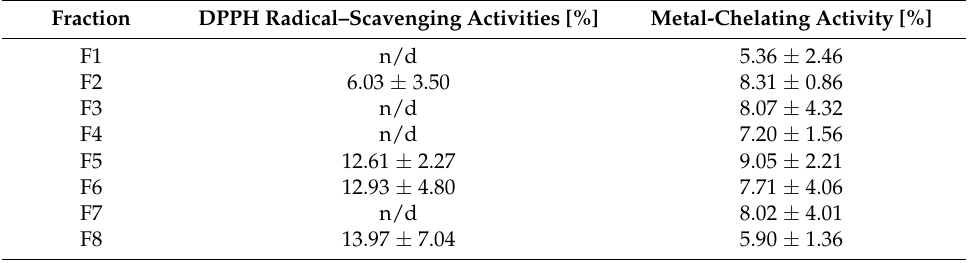
Table 2. DPPH radical—scavenging and metal-chelating activities of the fractions from gel